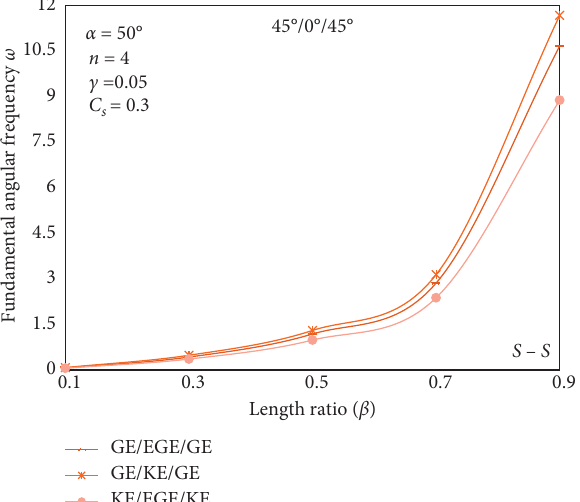
Figure 11: Influence of length ratio on the fundamental angular frequency of three-layered conical shells with different material combinations.